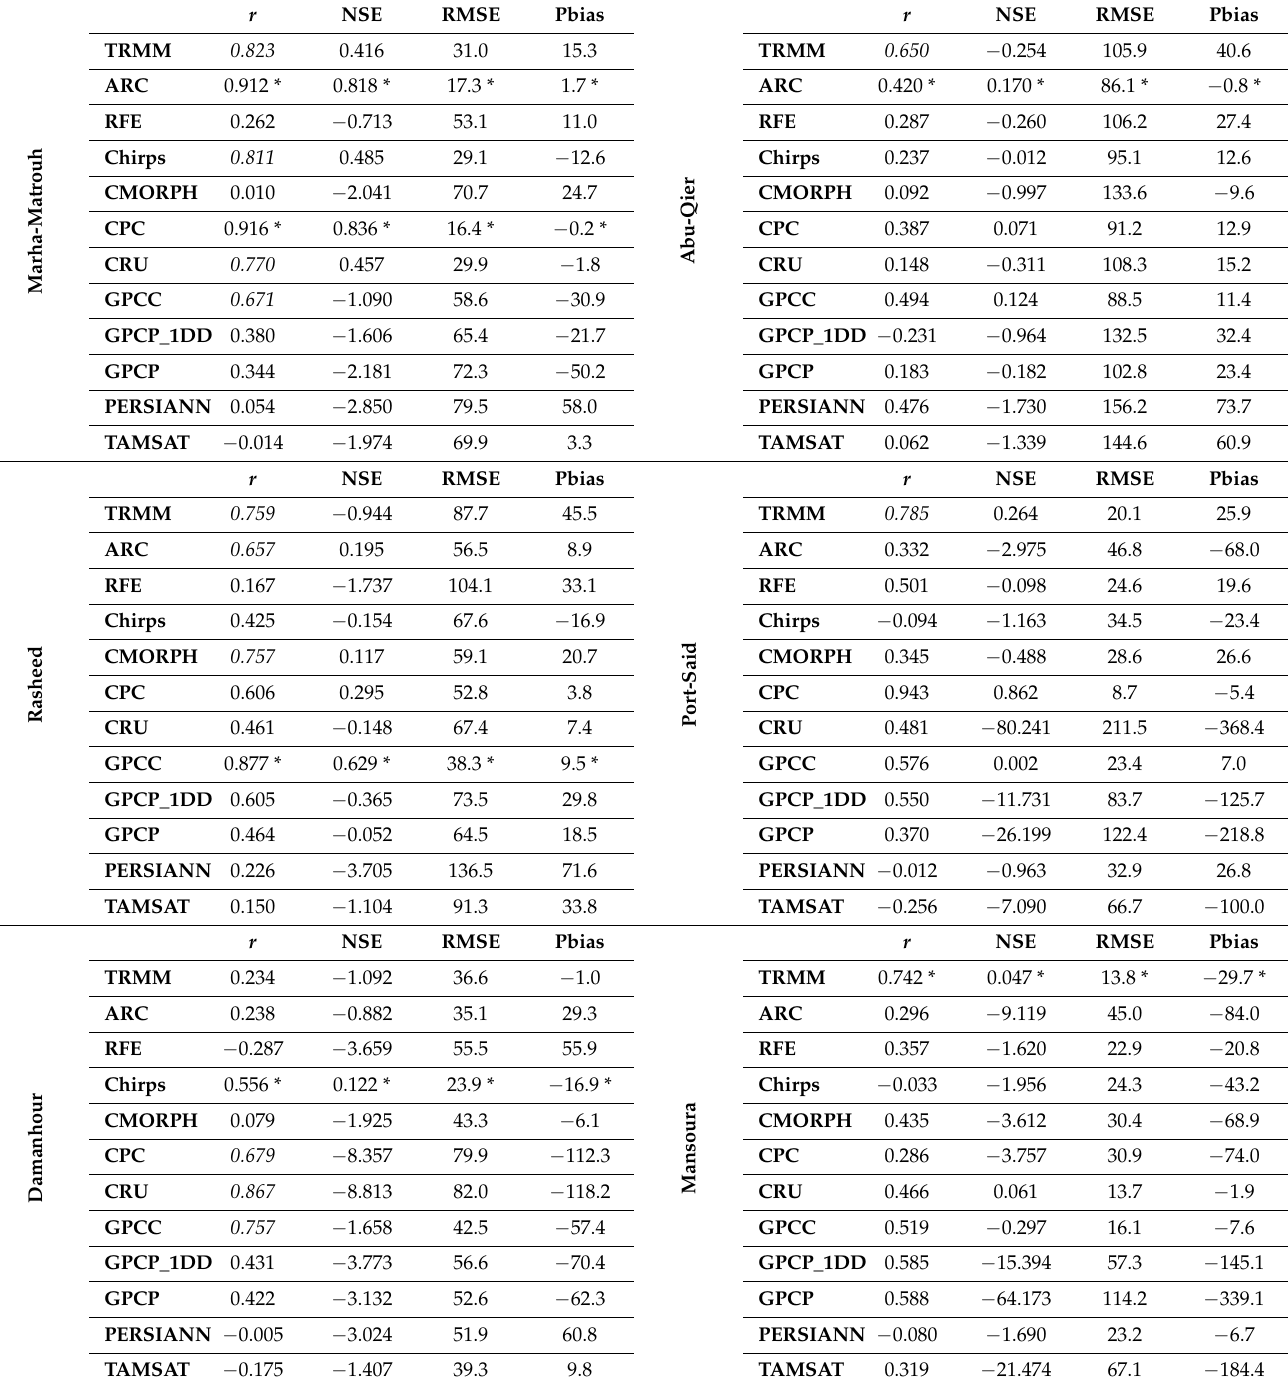
Table 3. Statistical evaluation indices of annual rainfall for the examined RP for studied